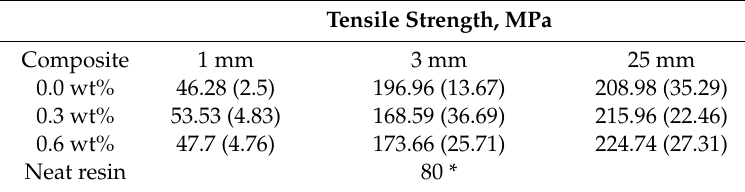
Table 3. The tensile strength of composites and neat resin.